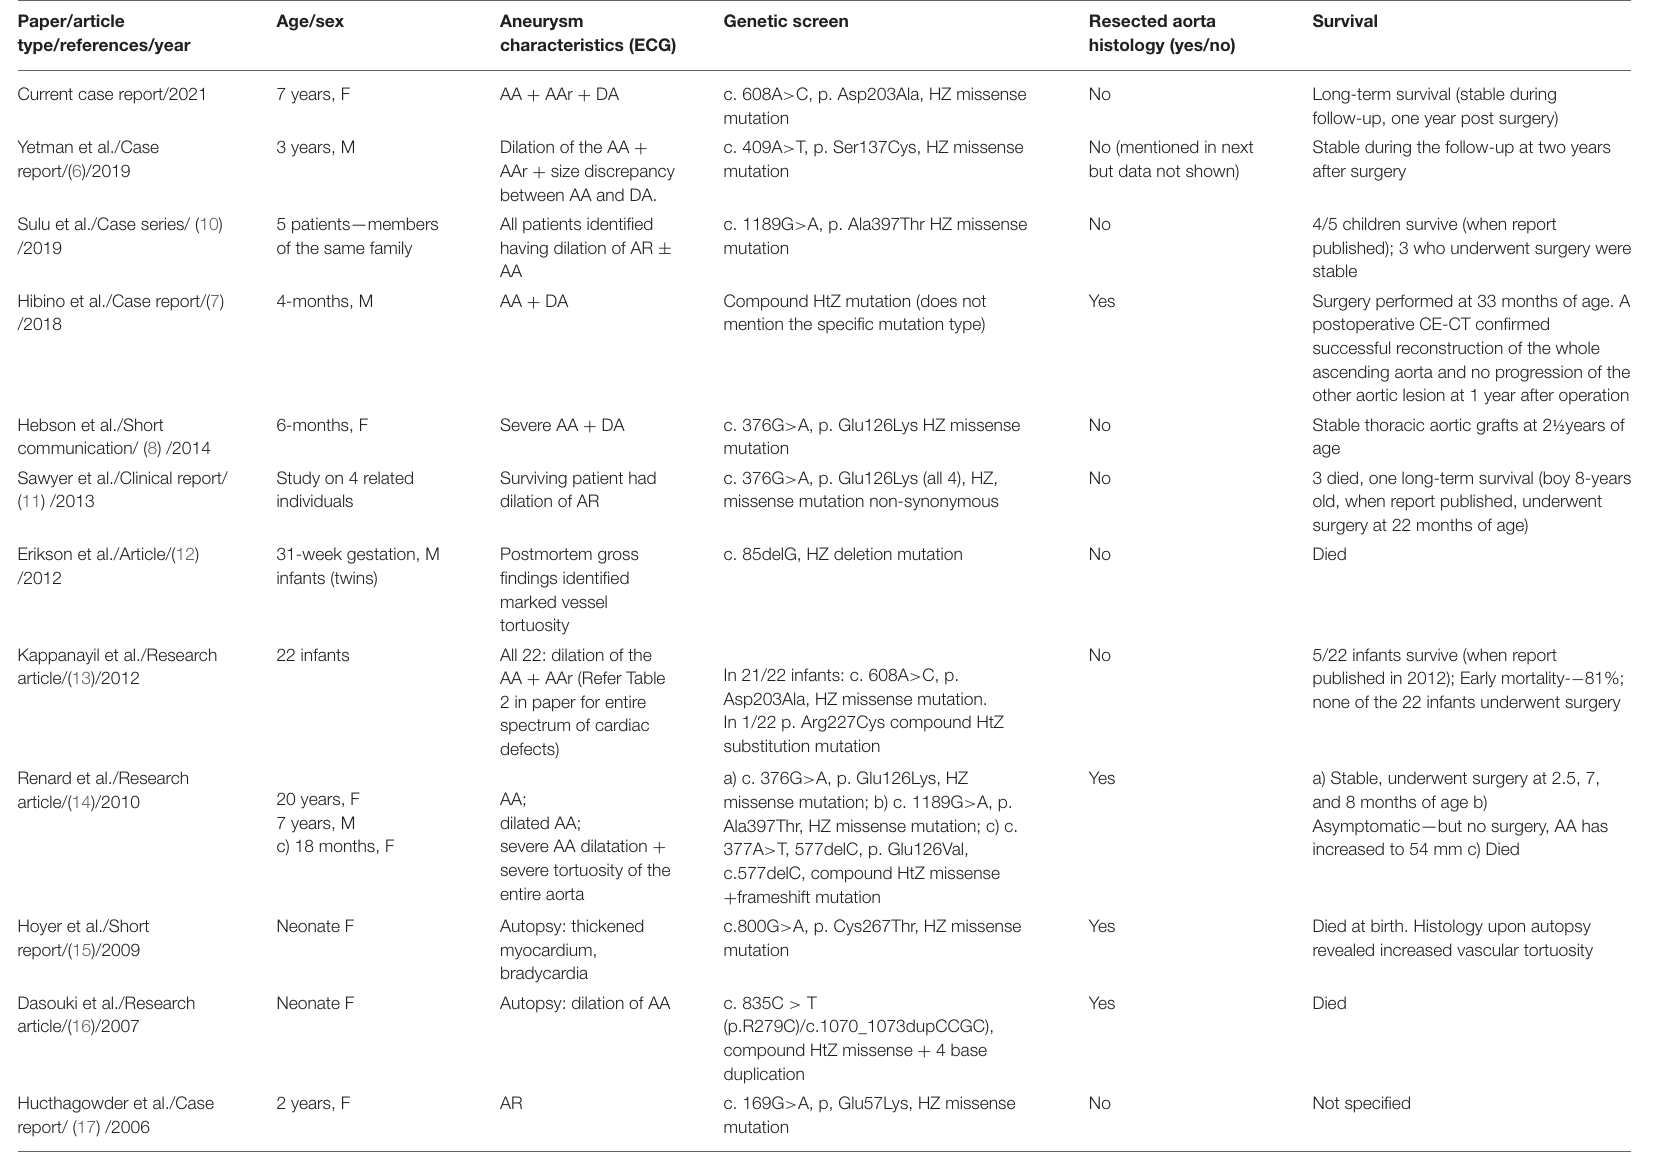
TABLE 1 | Summary of articles (12 including the current study) reporting occurrence of thoracic aortic aneurysms due to fibulin-4 deficiency (ARCL 1B) #